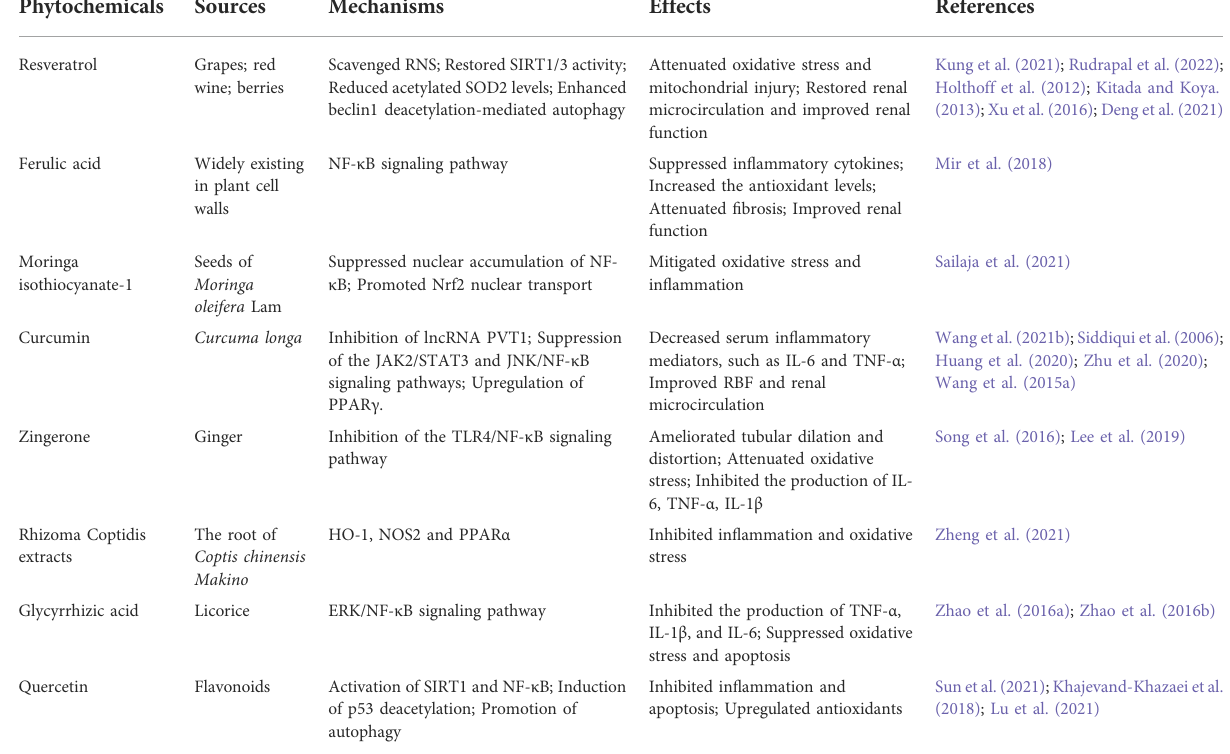
TABLE 1 Phytochemicals for treating sepsis-induced